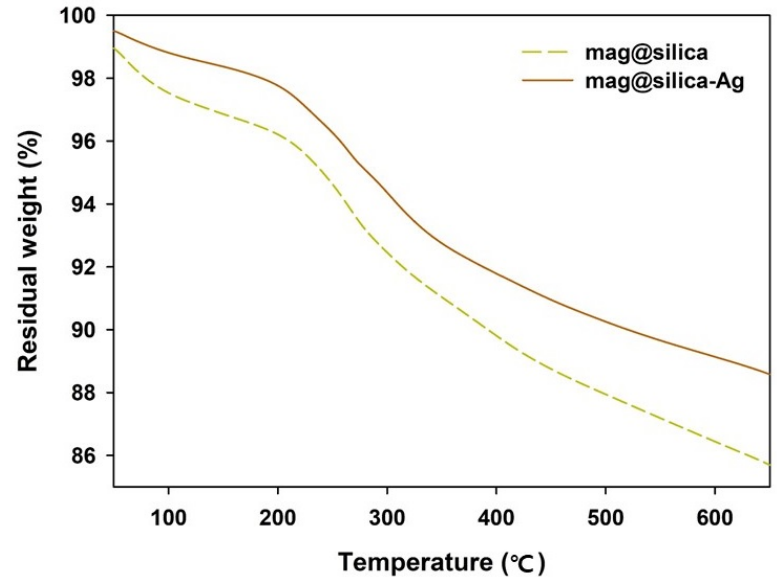
Figure 7. TGA curves of mag@silica and mag@silica-Ag composites.